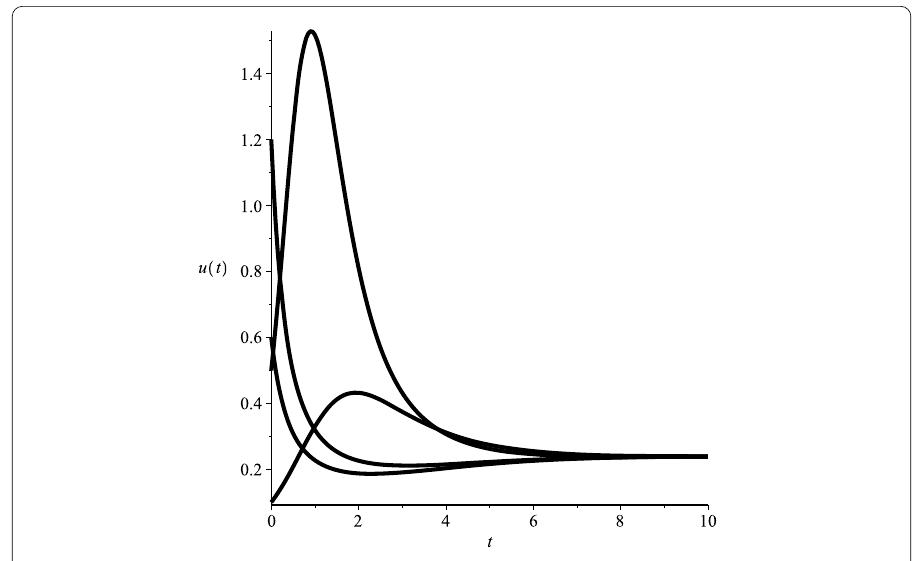
Figure 2 Dynamic behaviors of the prey species in system (5.3), the initial condition ( u (0), v (0)) = (0.1,0.5), (0.6,2),(0.5,0.2) and (1.2,2), respectively